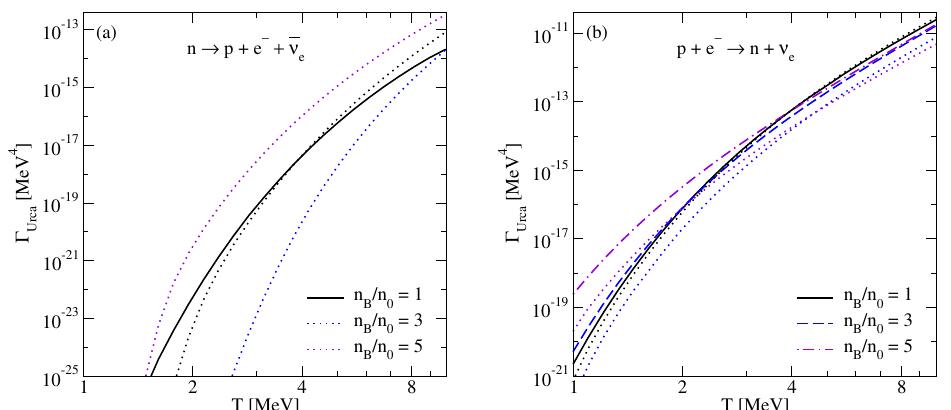
Figure 2. The rates of neutron e -decay ( a ) and electron capture ( b ) processes as functions of the temperature for various densities for neutrino-transparent matter. The dotted lines show the rates of the same processes computed in Ref. [18] within the approximation of nonrelativistic